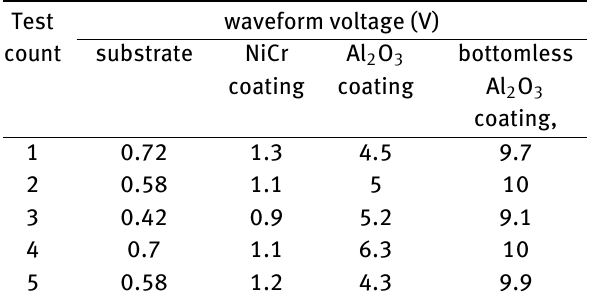
Table 3: Waveform voltage values of AE signals Test waveform voltage